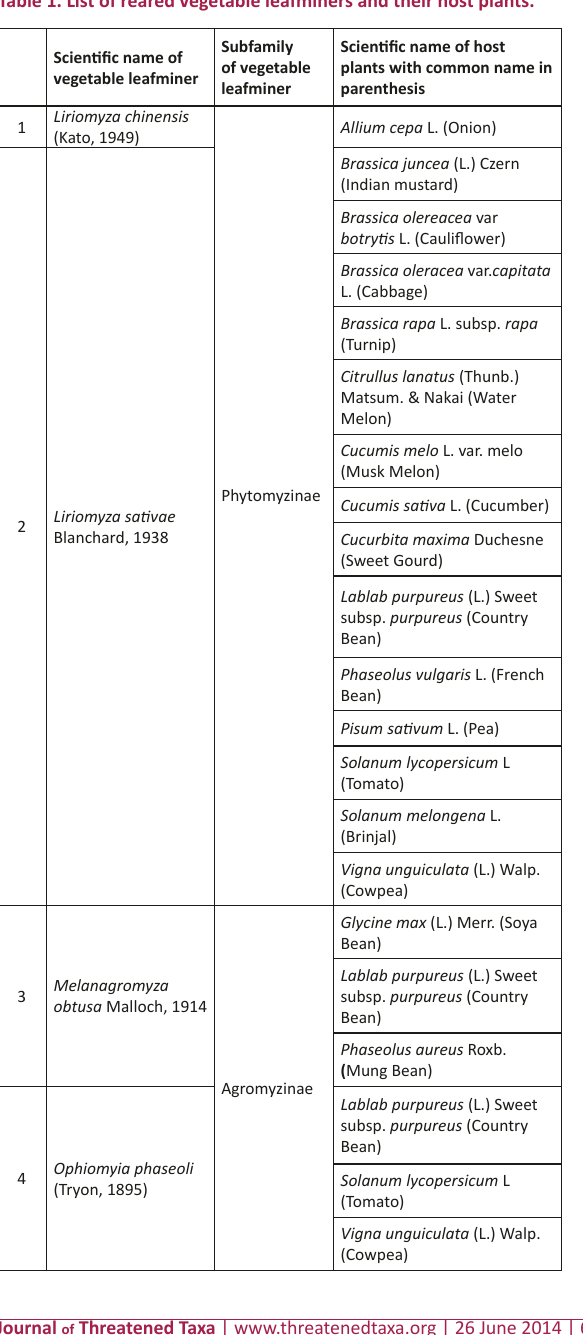
Table 1. List of reared vegetable leafminers and their host